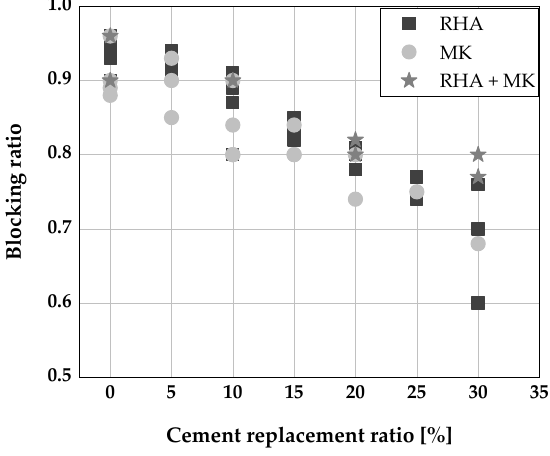
Figure 4. Blocking ratio of SCC: Chopra et al. [31] , Kannan [30] , Gill [61] , Madandoust [34] .